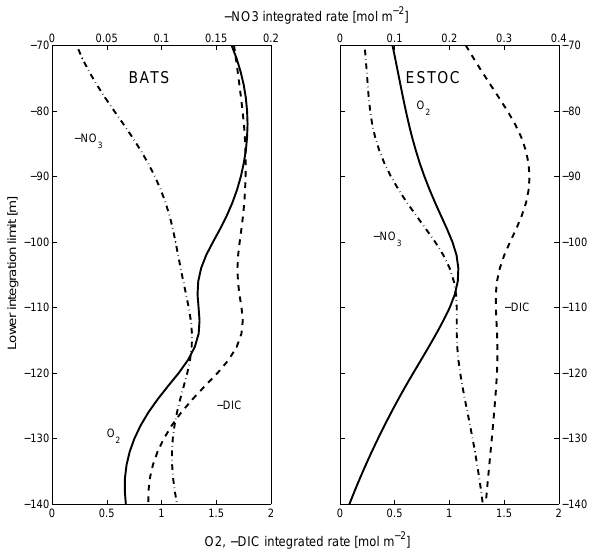
Fig. 7. Time and depth-integrated net production rates as a function of the lower limit used for the integration at BATS and ESTOC for oxygen (solid), DIC (dashed) and nitrate